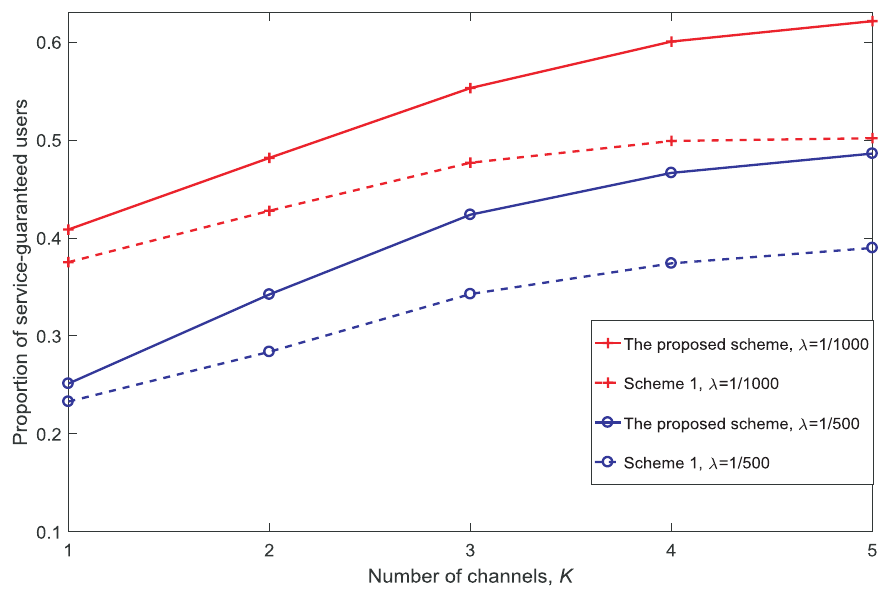
Proportion of service-guaranteed users for different numbers of channels K ( d V = 10, V = 10, N = 5 ) .